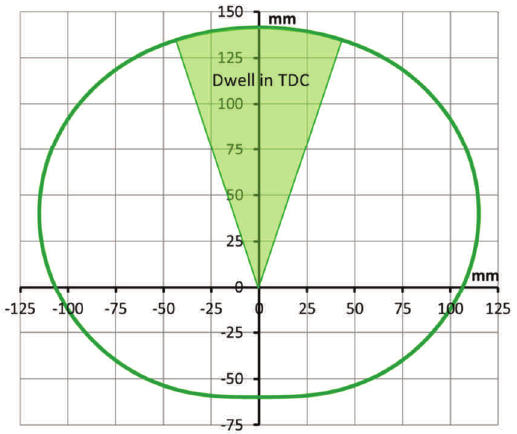
Fig. 9. Final result of cam's outline